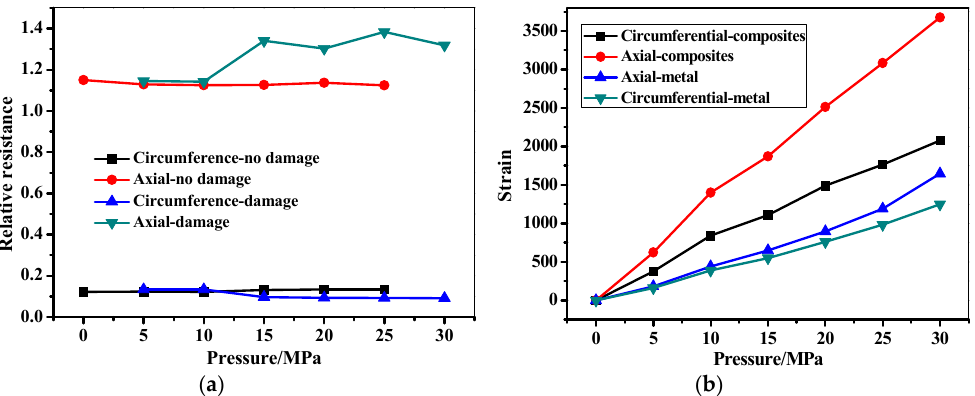
Figure 18. The in-situ monitoring of the health filament wound pressure vessel before